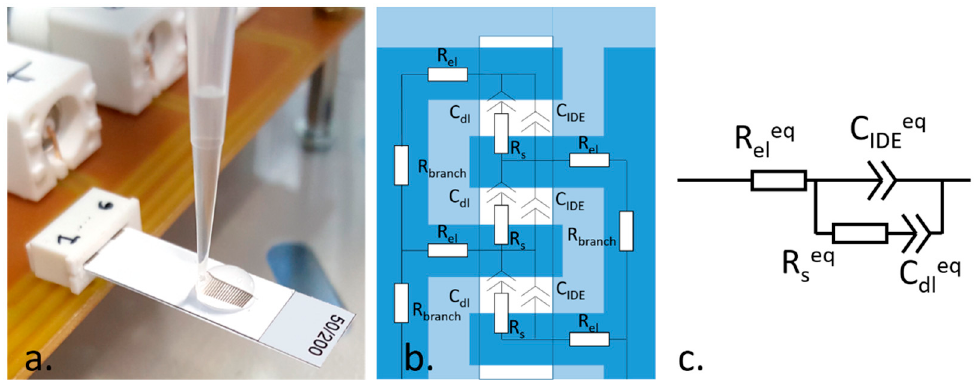
Figure 1. ( a ) Picture of an inkjet-printed interdigitated electrodes (IDE) sensor insulated by the vinyl adhesive layer and connected to the custom printed circuit board (PCB) board by a flat ribbon connector; ( b ) scheme of the IDE electrodes electrical equivalent elements (not in scale); ( c ) electrical equivalent model of the IDE sensors.